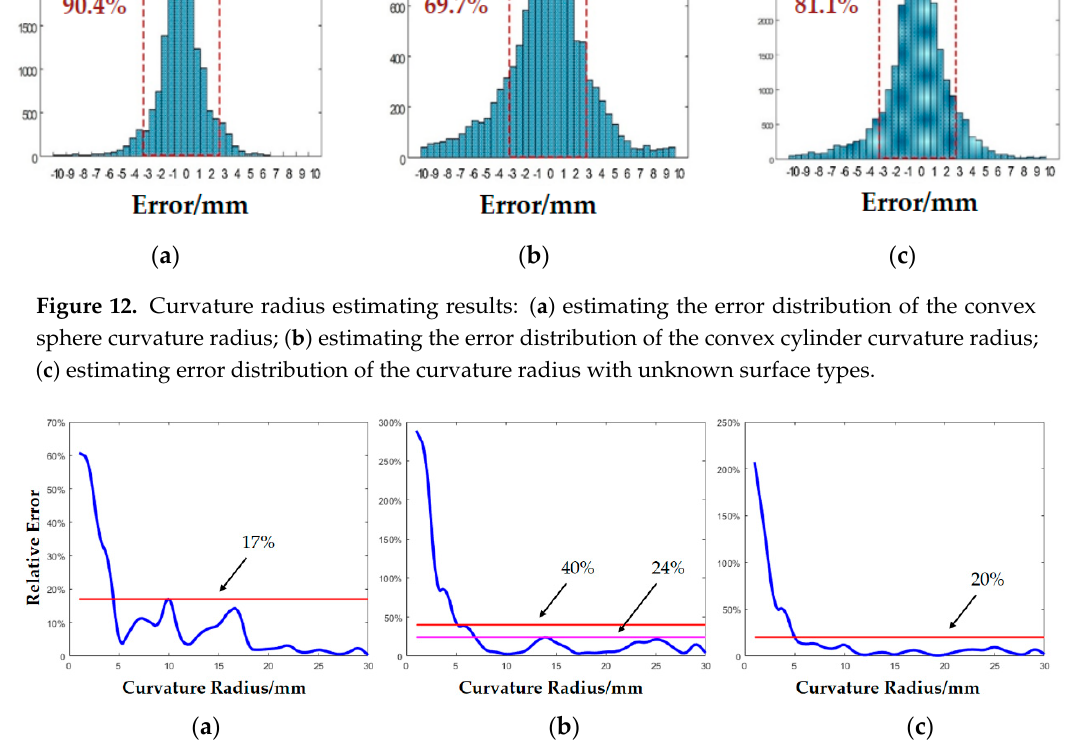
Figure 13. The mean relative error distribution of curvature radius estimation. ( a ) Curvature estimation results of model A for sphere. ( b ) Results of model B for cylinder. ( c ) Results of synthetic model C for all types.